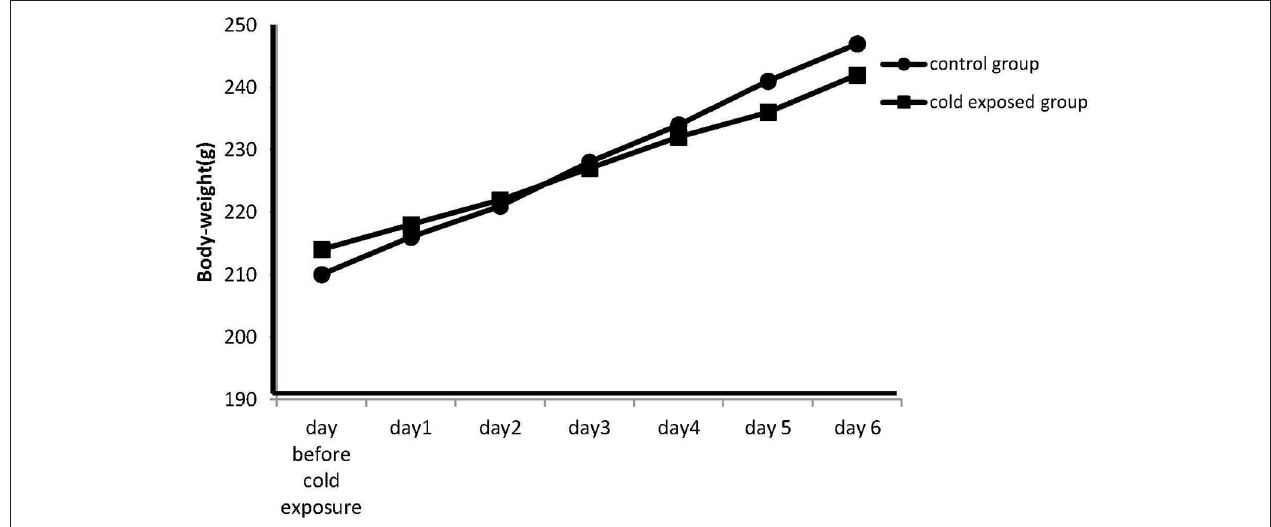
FIGURE 1 | Effect of cold stress on the body weight . Data are represented as the mean S.E.M. of body-weight measured at 09:00 h daily before the exposure. Differences in body weight gain between controls and stressed rats are not statistically significant during any time period of the study ( P < 0.07; n = 7 per group).However the p nearing 0.05 seem to suggest that increasing the number of observation the difference could be